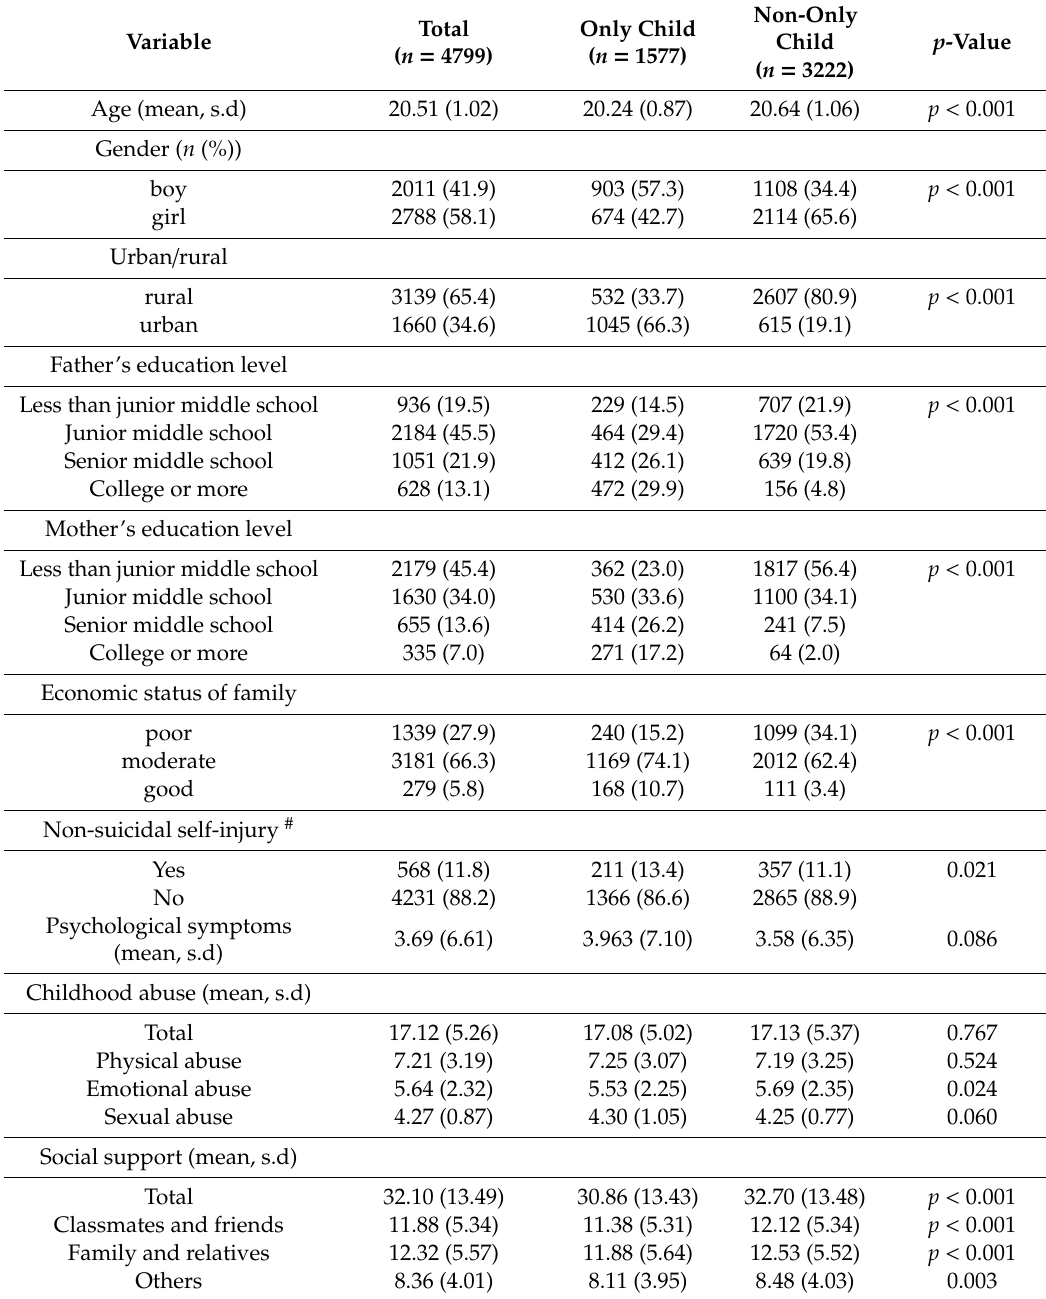
Table 1. Characteristics of participants by only-child, data shown as n (%) / M ( SD ).